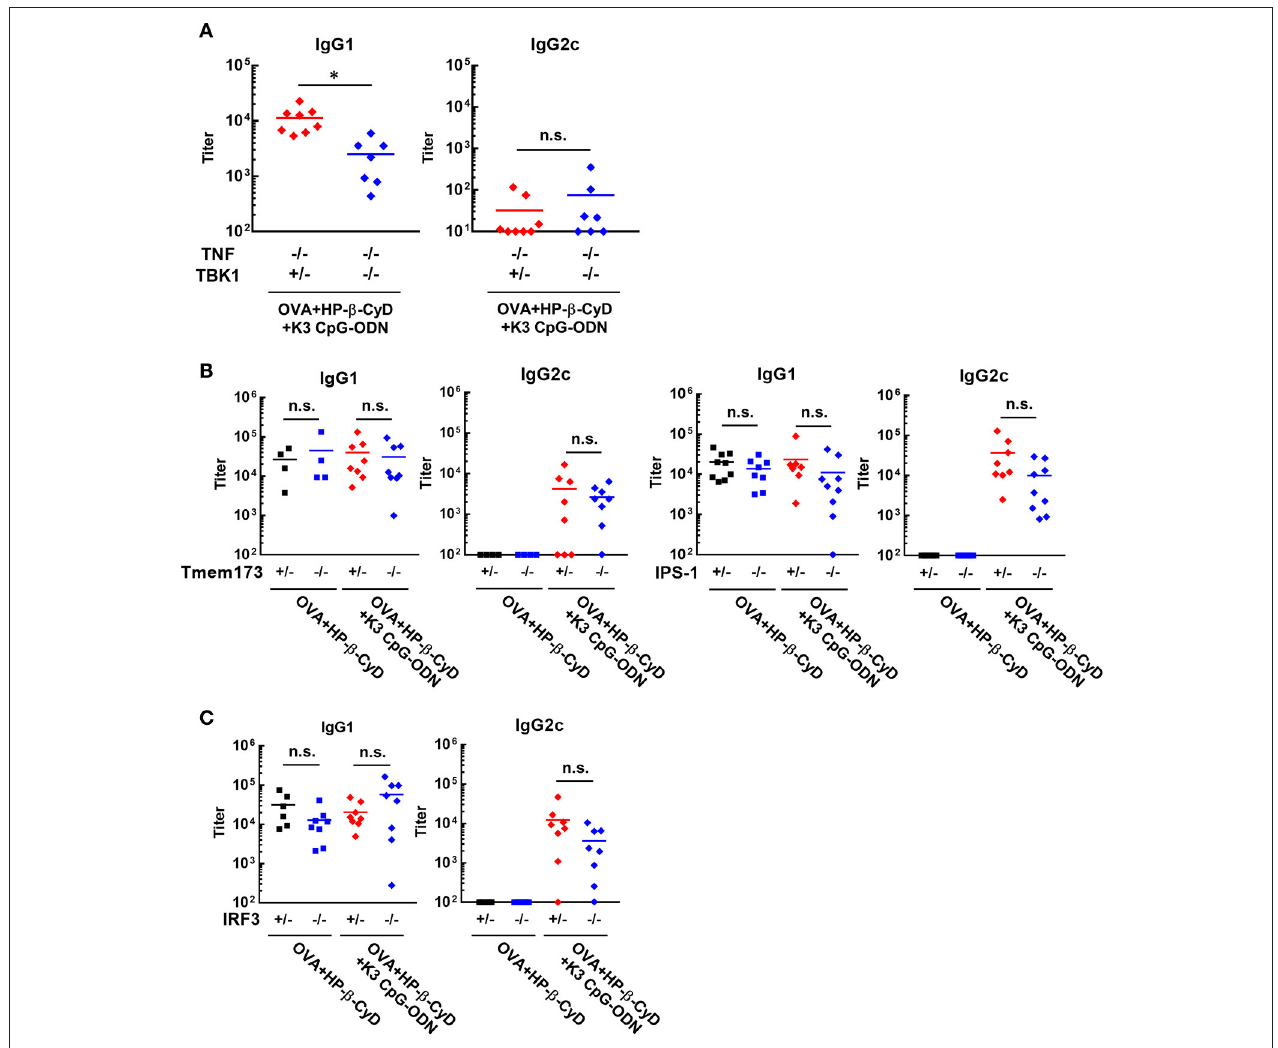
FIGURE 3 | Induction of type-2 immune responses by HP- β -CyD and K3 CpG-ODN is dependent on TBK1. (A–C) C57BL/6 mice ( A ; Tnf − / − Tbk1 + / − or Tnf − / − Tbk1 − / − , B ; Tmem173 + / − or Tmem173 − / − , Ips-1 + / − or Ips-1 − / − , C ; Irf3 + / − or Irf3 − / − ) were inoculated with 3 µ g of OVA solution containing 30% HP- β -CyD and 10 µ g of K3 CpG-ODN into the base of the tail on day 0 and 14. Blood was collected 7 days after the boost. Anti-OVA IgG1 and IgG2c were determined by ELISA. Each dot represents an individual mouse ( A ; n = 7–8, B ; n = 4–9, C ; n = 6–8 per group in two independent experiments, blue; gene deficient mice). * p < 0.05, n.s., not significant (Student’s t -test or one-way ANOVA with Bonferroni’s multiple comparison